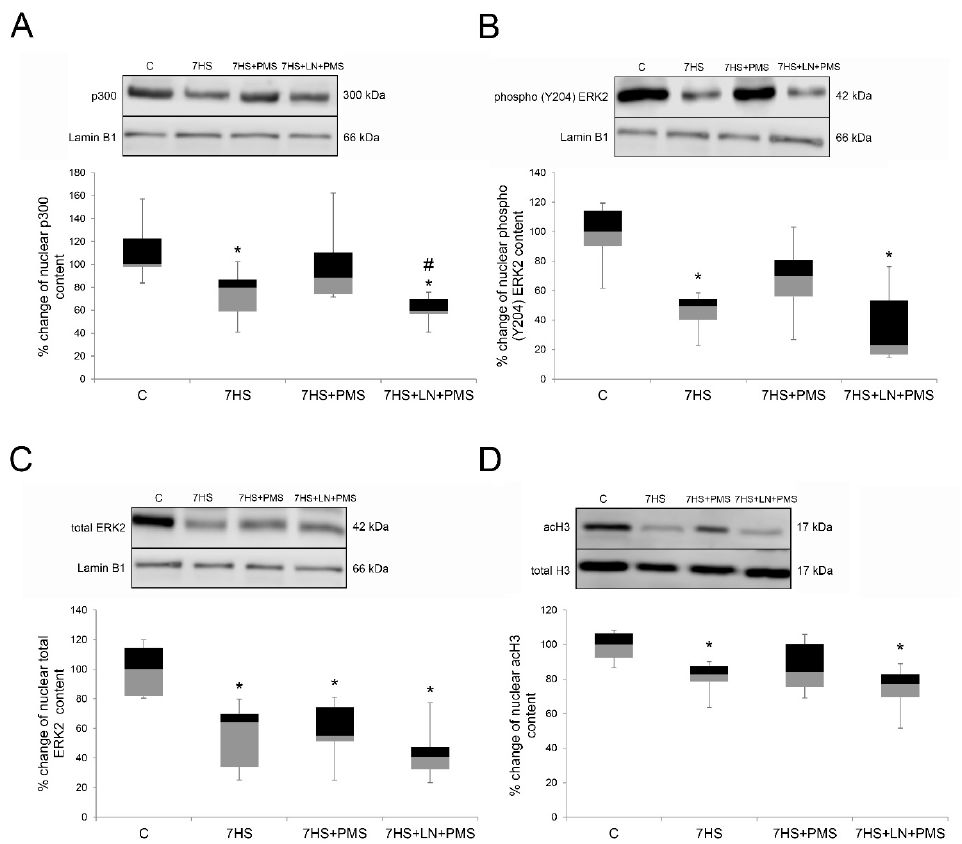
Figure 7. Western-blot analysis of p300 ( A ), phospho-ERK2(Y204) ( B ), total ERK2 ( C ) and acH3 ( D ) nuclear content in rat soleus muscle in control group (C), 7-day hindlimb-suspended group (7HS), 7-day hindlimb suspended group with plantar mechanical stimulation (7HS + PMS), 7-day hindlimb suspended group with plantar mechanical stimulation+ L-NAME introduction (7HS + LN + PMS). Data are shown as % of the control group. *—significant difference from the control group. &—significant difference from 7HS group. #—significant difference from 7HS + PMS group ( p < 0.05). Box plots show 25– 75 percentiles and median values and the whiskers represent the minimum and the maximum; n = 8/group.